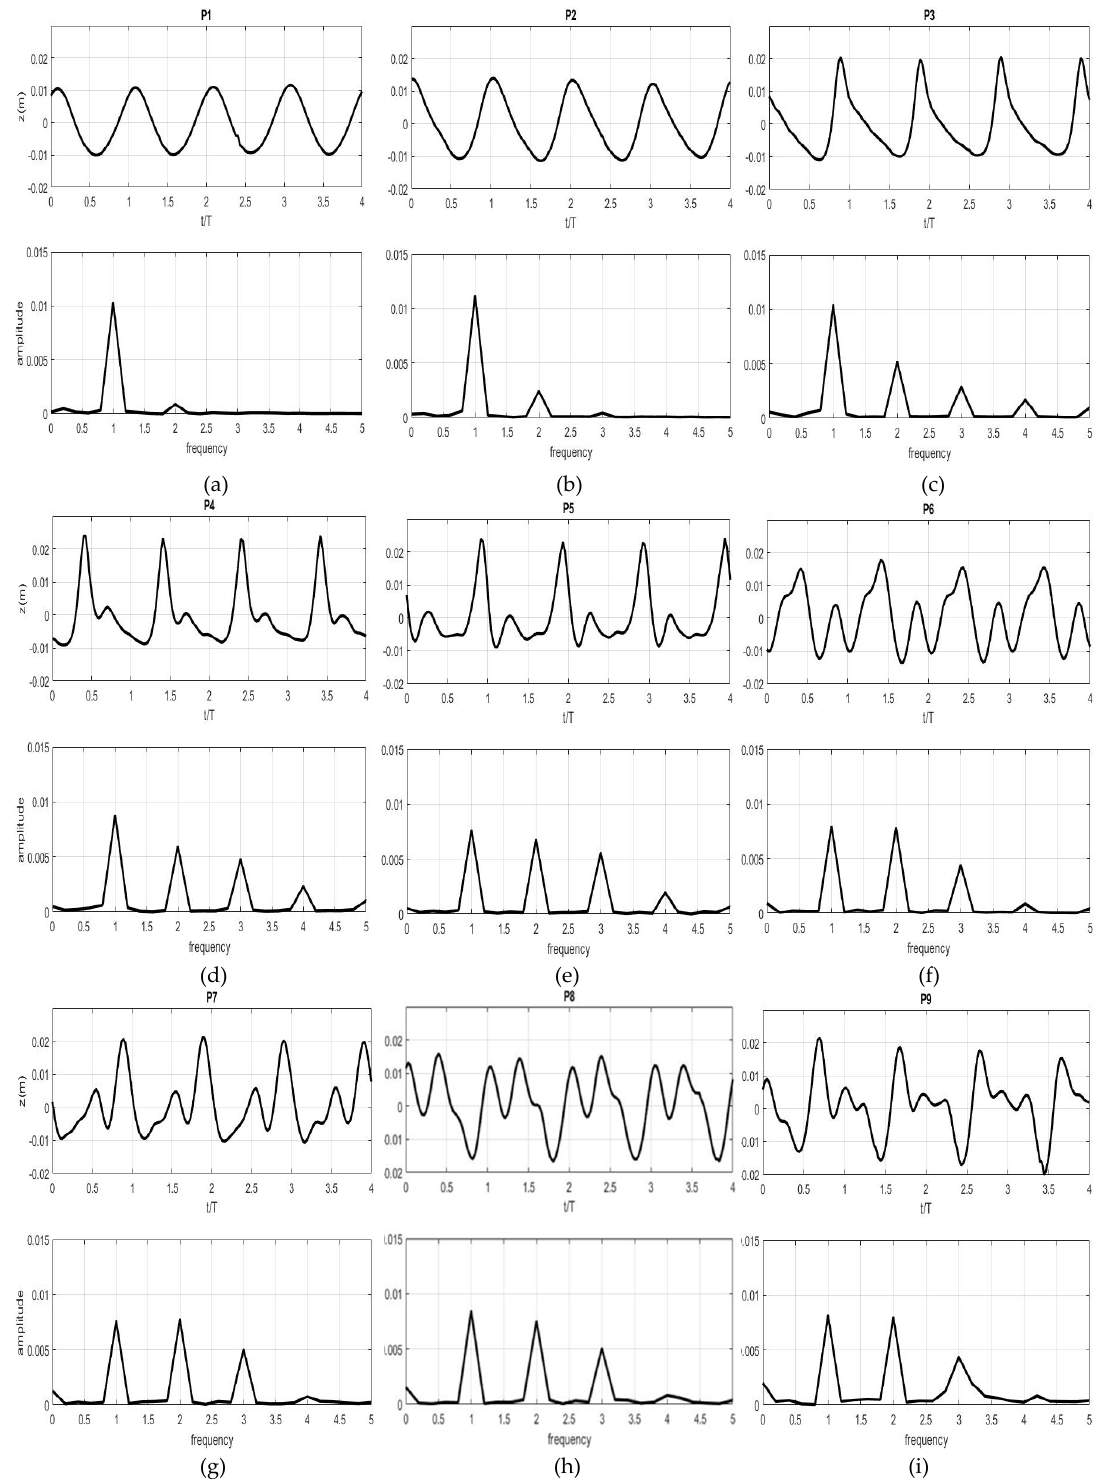
Figure 7. Simulation of surface elevations (upper) and amplitude spectra (lower) at nine downstream positions with the incident wave height H i = 0.02 m and period T = 2.02 s passing over the trapezoidal submerged structure. ( a ) Station P1; ( b ) Station P2; ( c ) Station P3; ( d ) Station P4; ( e ) Station P5; ( f ) Station P6; ( g ) Station P7; ( h ) Station P8; ( i ) Station P9.